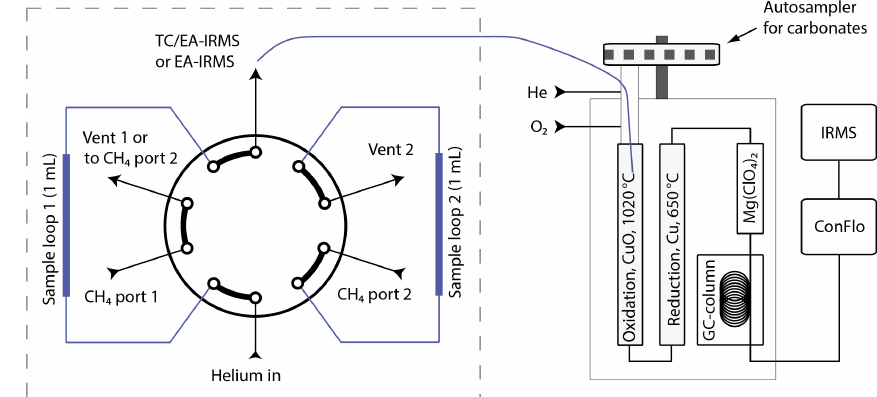
Figure 4. The 10-port valve for manual CH 4 injections is coupled to the EA–IRMS system through custom-made gas inlet into combustion (oxidation) unit for δ 13 C–CH 4 calibration. The proportions of illustrated components are chosen to increase clarity.